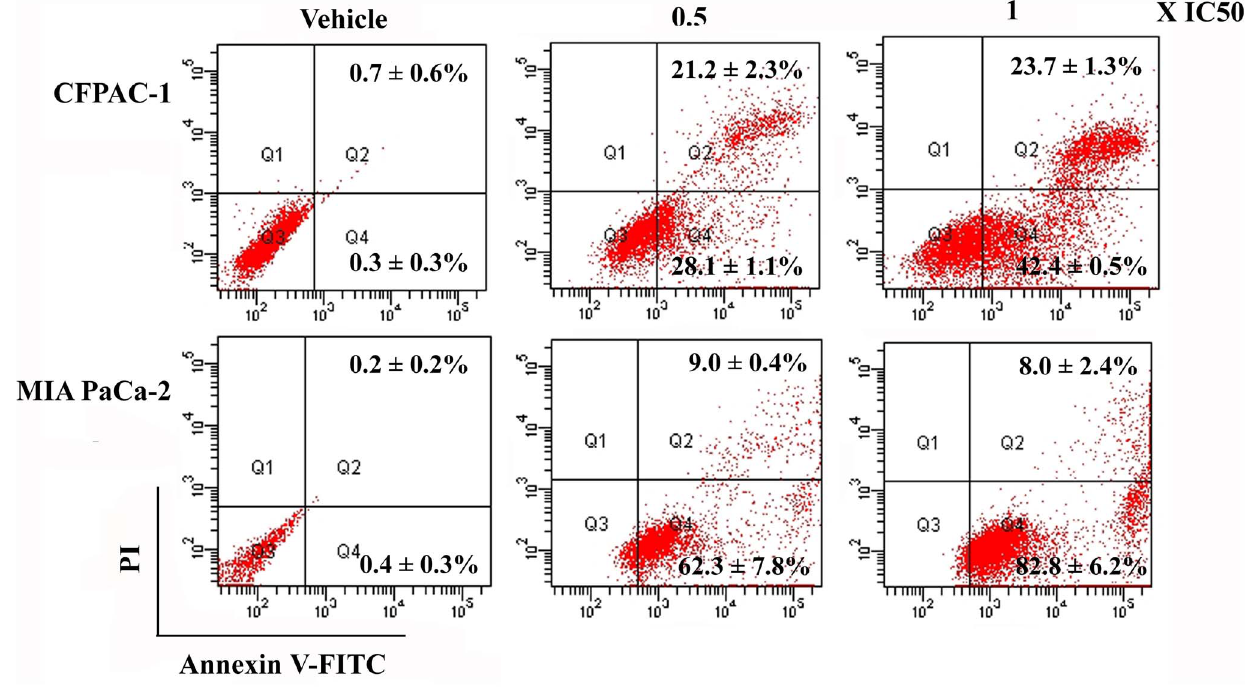
Figure 3. Spiclomazine induces apoptosis. Extent of apoptosis induced by spiclomazine was measured by FCM. Representative results from three independent experiments are shown; and results are presented as the mean 6 SD of percent apoptotic cells from three independent experiments.